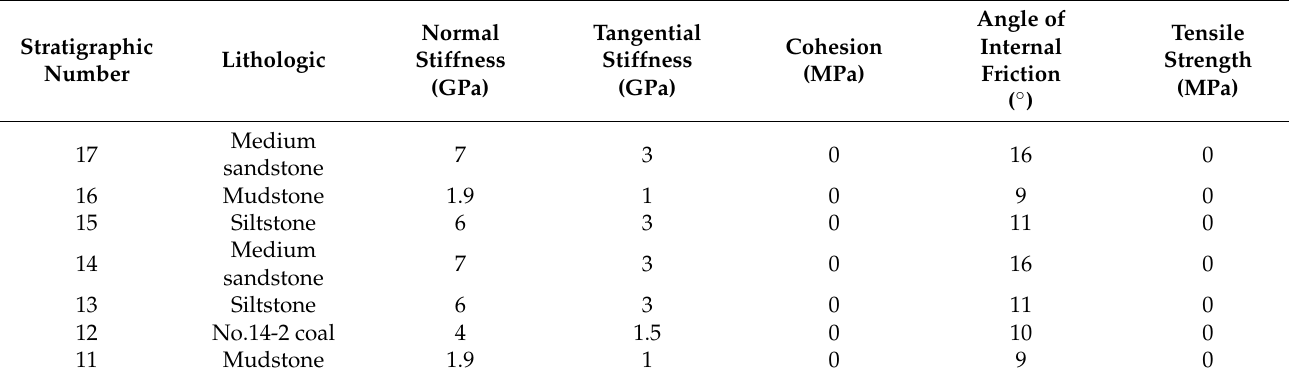
Table 2. Table of mechanics parameter of model overburden